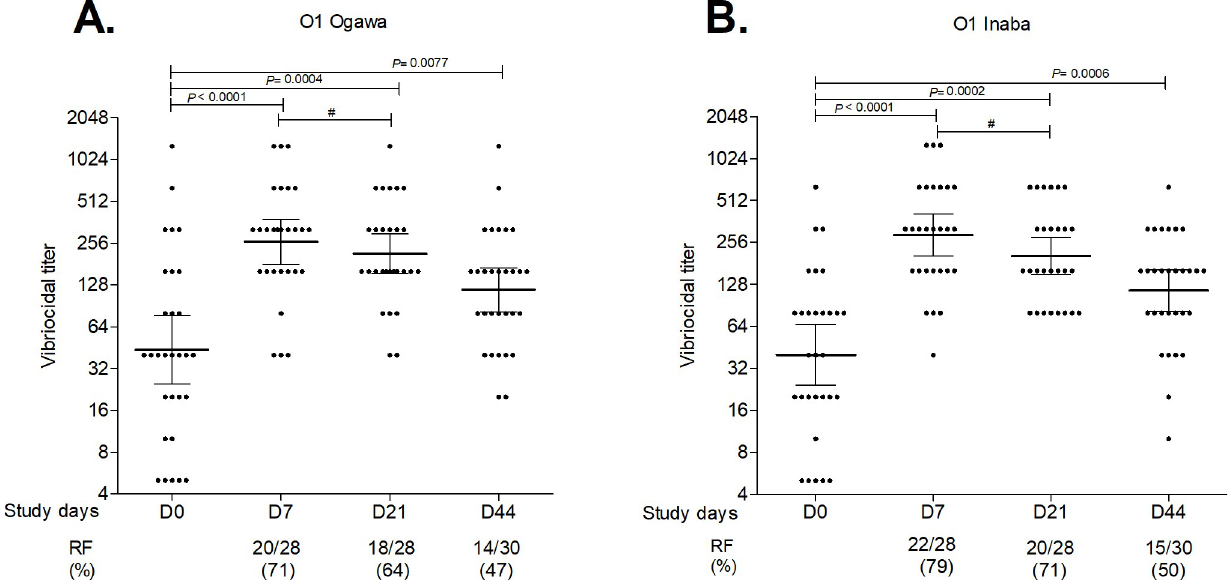
Fig 1. Plasma vibriocidal antibody responses. Geometric mean titer (with 95% CI) of vibriocidal responses to V . cholerae O1 Ogawa (A) and Inaba (B) in Bangladeshi adults who received two doses of Shanchol vaccine separated by 2 weeks (day 0 and day 14) are represented. Each dot represents an individual vibriocidal antibody titer, horizontal bars represent geometric means (GM) and error bars indicate 95% confidence intervals. The Wilcoxon signed-rank test was used for analyses of the data. P values are indicated where statistically significant differences were obtained from baseline (day 0). Responder frequencies (RF) are also listed. # indicates statistically significant decreases in vibriocidal antibody titers in vaccinees between 7 days after the first and second dose of vaccination (at day 7 and day 21) (P � 0.05).